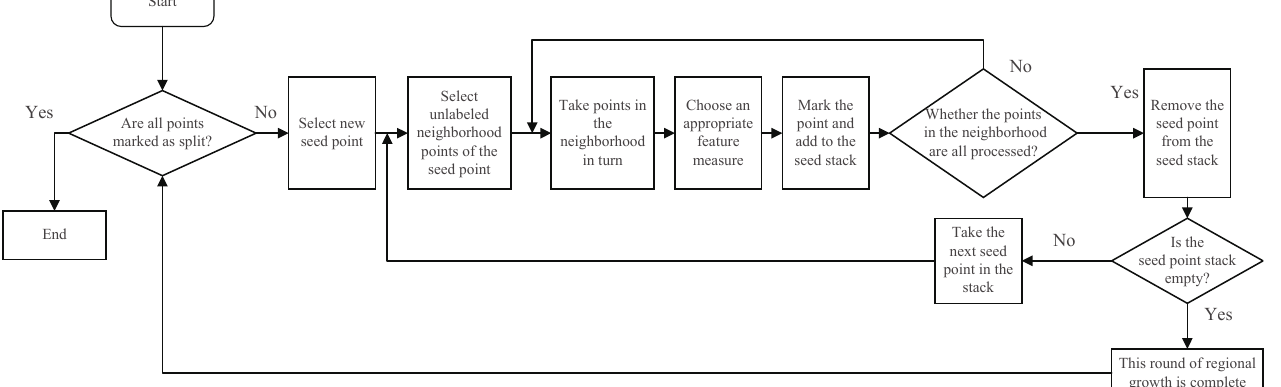
Figure 5. The flow chart of segmentation of point cloud based on region growing method. Segmentation of the point cloud based on the region growing is a segmentation algorithm based on the surface. The algorithm extends outward from the seed point, and according to the angle between the normal vectors of the point cloud, the adjacent points that meet the characteristic change range are classified into one class to form different regional divisions. To some extent, the selection of seed points determines the effect of the final point cloud segmentation. Therefore, in order to improve the efficiency and accuracy of the point cloud segmentation, the CAD model is used as the prior condition of point cloud segmentation, and the CAD model is divided into different feature regions, as shown in Figure 6. Some data points in each region are selected as the initial seed points to segment the whole point cloud data. Divide the CAD model into different feature regions and choose suitable points in each region as the growth seed is completed by manual operation. It is a process of extracting prior information from CAD models.